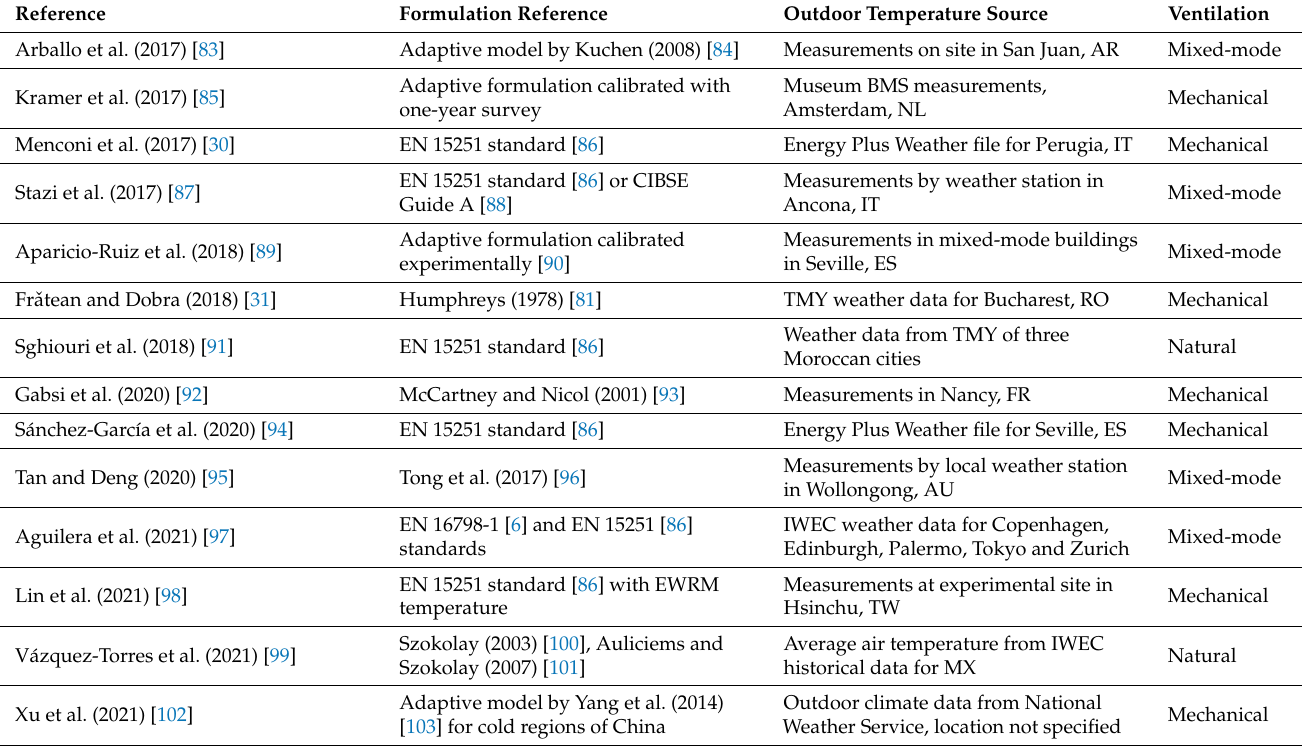
Table 7. Adaptive thermal comfort models in reviewed contributions.